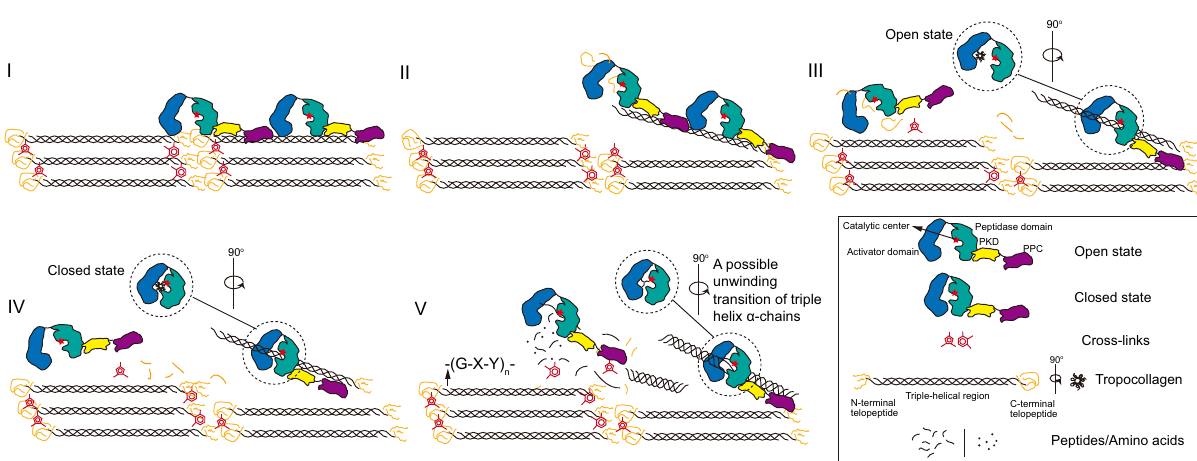
structure information. VhaC from Vibrio harveyi VHJR7 is a true